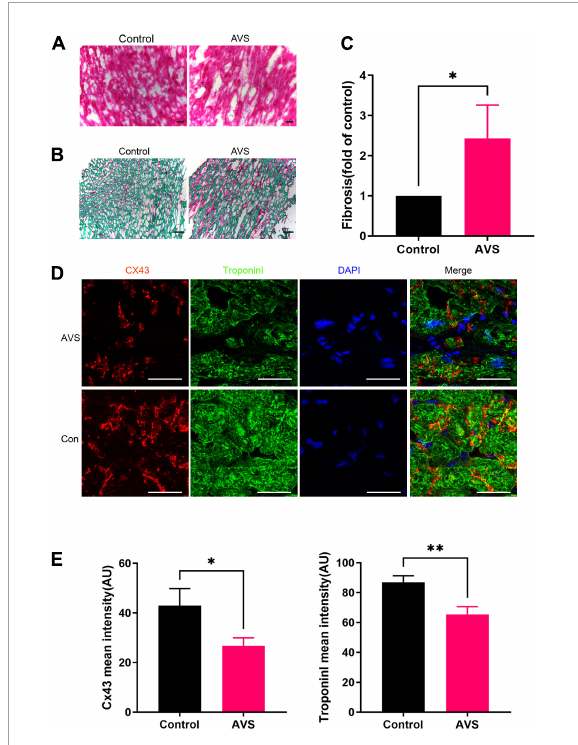
FIGURE1 Myocardial characteristics of aortic valve disease. (A) HE staining of myocardial tissue sections. (B,C) Sirius red staining of myocardial tissue sections and its quantification analysis, fast green as background color, ∗ P < 0.05; (D) immunofluorescence staining of Cx43 (red) and Troponin I (green) in the myocardium. Scale bar = 100 µ m, AVS, Aortic Valve Stenosis; Con, Control; (E) remarkably fading of Cx43 and Troponin I fluorescent intensity were observed in AVS myocardium. ∗ P < 0.05, ∗∗ P <